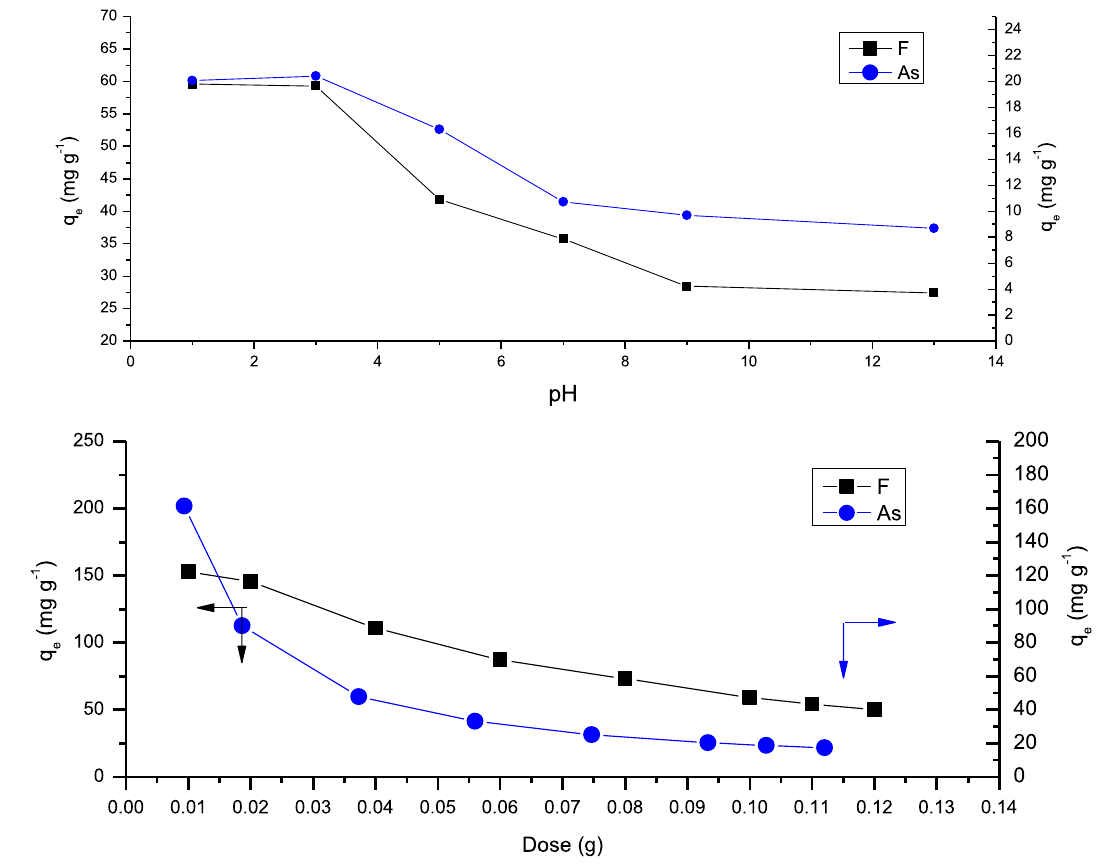
Fig. 8 Plots showing effect of pH and adsorbent dose on adsorption capacity of Fe-KWC for fluoride (black-shaded square) and arsenic (blue- shaded circle) Fig. 9 Fitting of adsorption models for adsorption of fluoride ( a ) and Arsenic ( b ) on